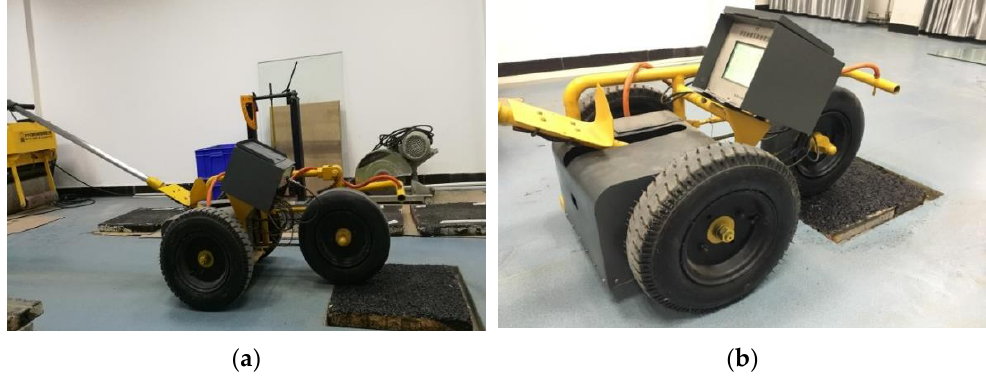
Figure 3. The Walking Friction Tester. ( a ) Test wheel contact the specimen; ( b )Test procedure.